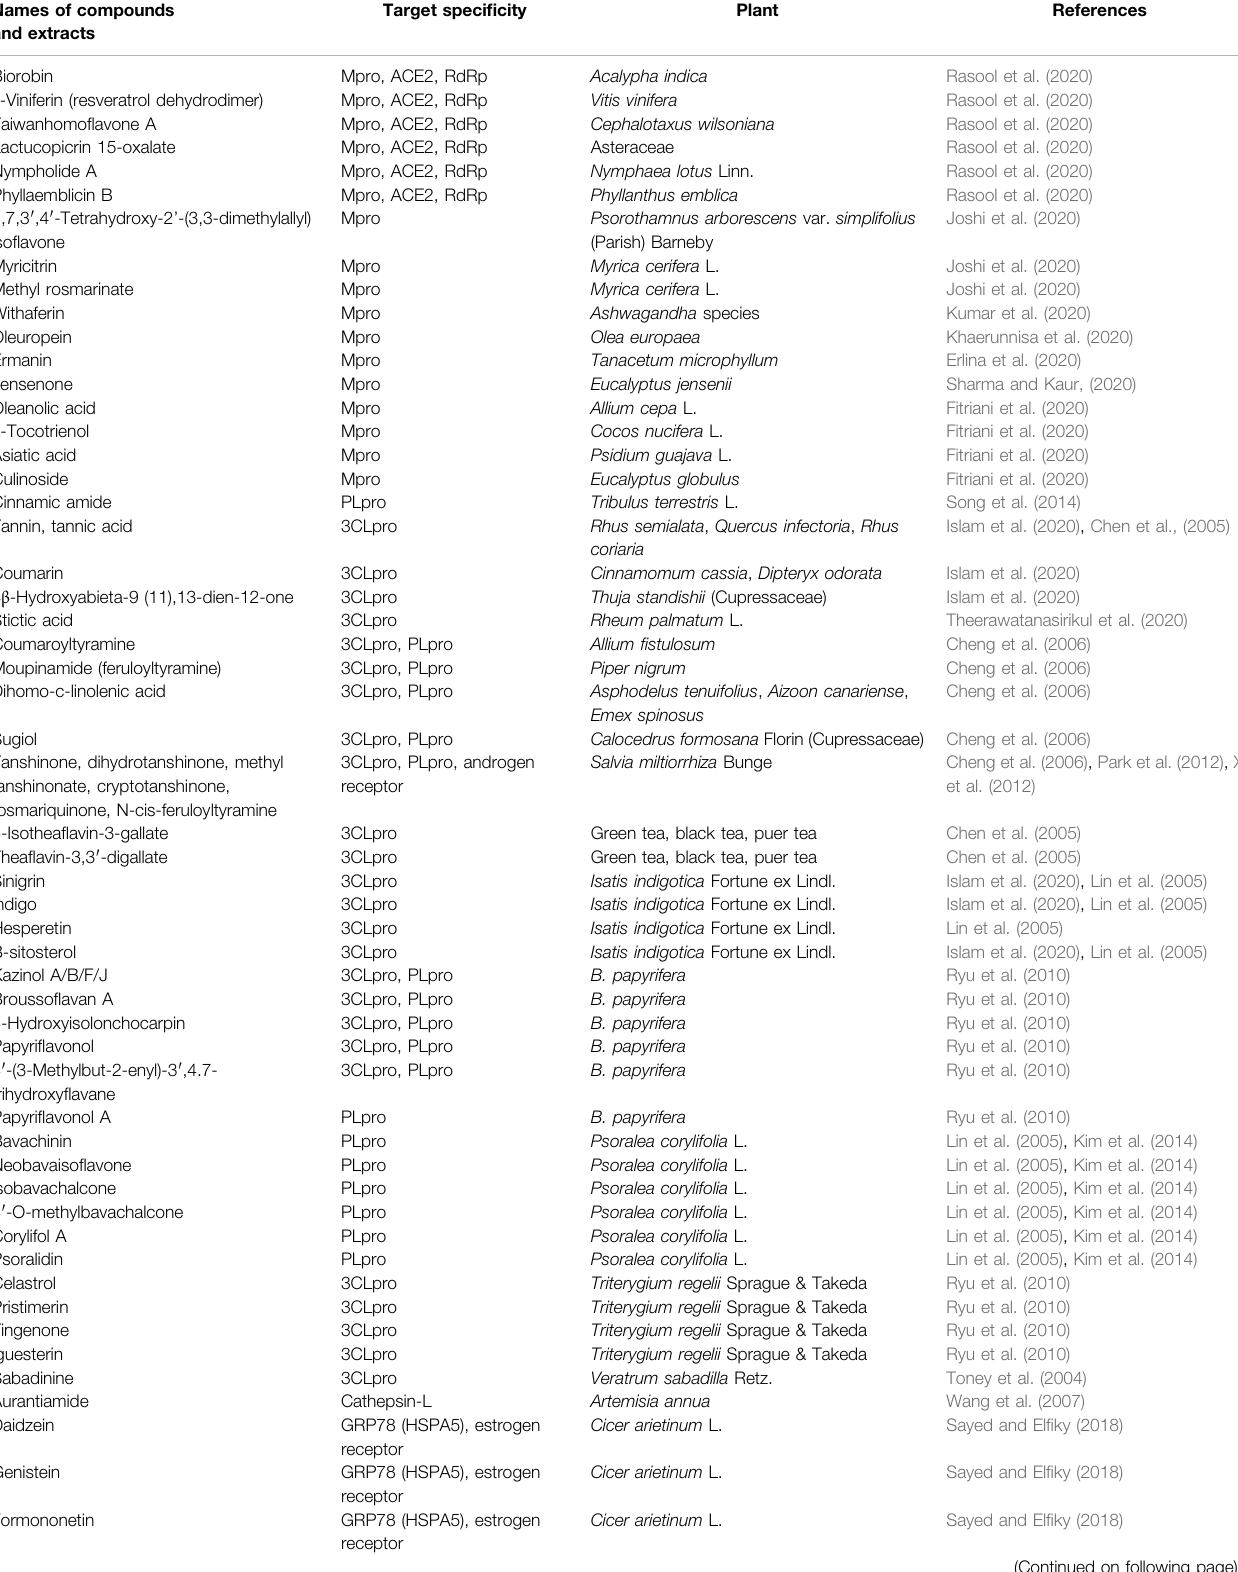
TABLE 1 | ( Continued ) Summary of anti-CoV compounds and